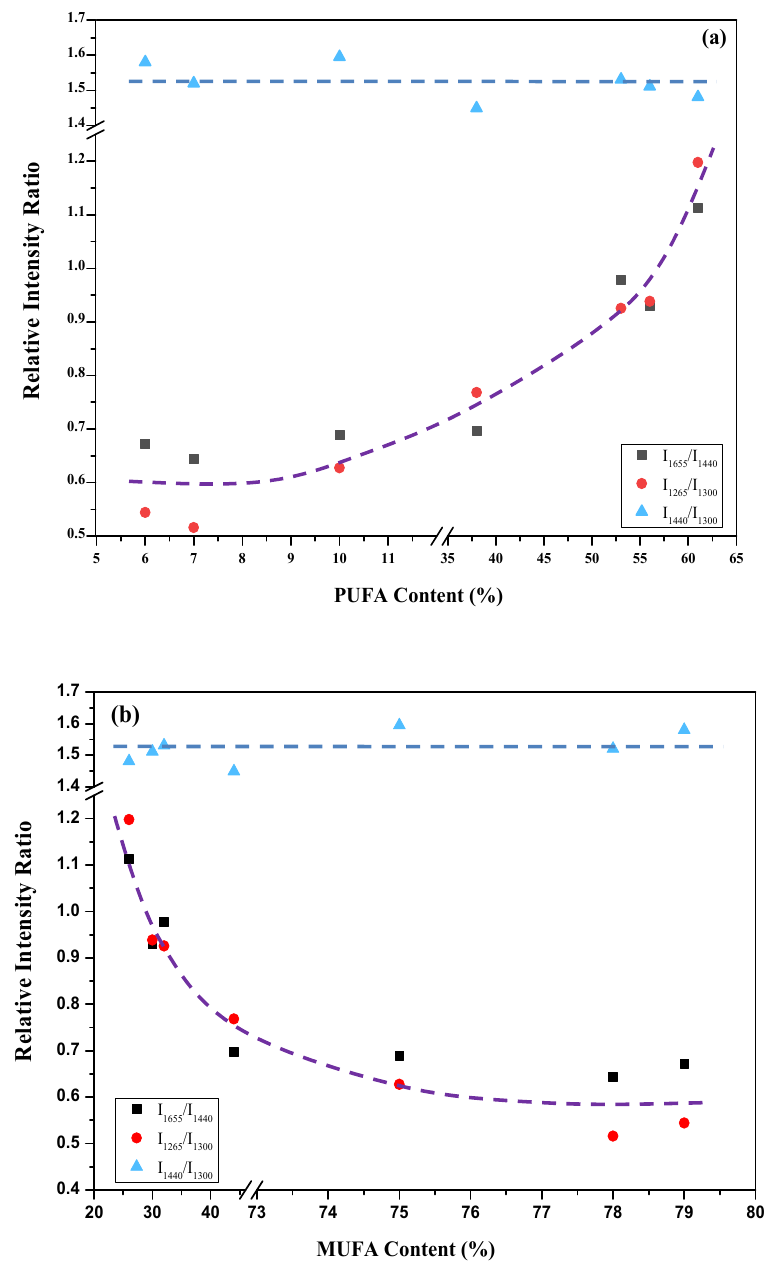
Figure 3. Relative intensity ratios of I 1655 / I 1440 (square), I 1265 / I 1300 (dot), and I 1440 / I 1300 (triangle) as a function of the content of PUFA ( a ) and MUFA ( b ). The curves are not fitted, they simply show the trend how the relative intensity ratios change. The error bars of the relative intensity ratios were estimated to be about 10%, mainly caused by baseline corrections.